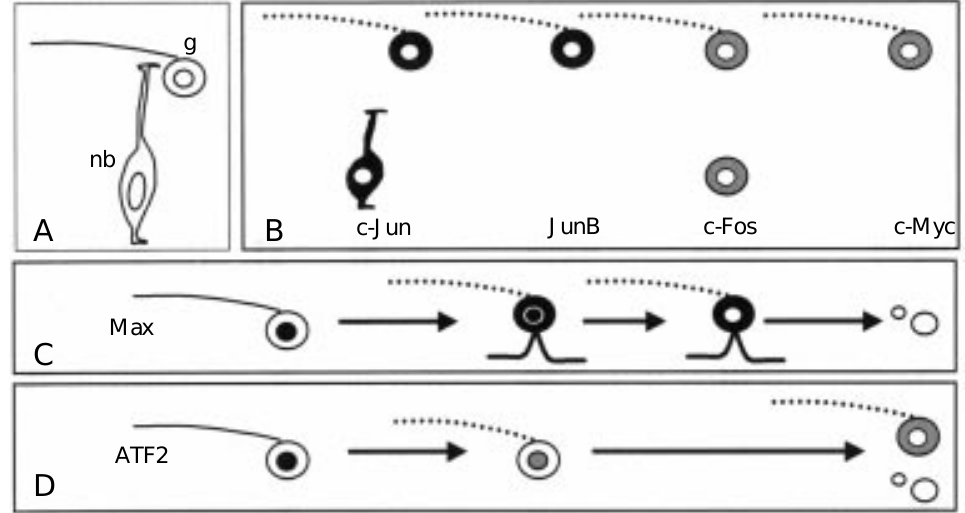
Figure 3 - Nuclear exclusion of transcription factors in retinal ap- optosis. A , Symbolic depiction of retinal ganglion cells (g) and neuroblasts (nb). B , Representa- tion of the location of immunore- activity detected for 4 transcrip- tion factors in the cell types de- picted in A. Immunoreactivity for c-Fos and c-Myc was less in- tense than obtained for c-Jun and JunB in our conditions. C and D , The course of nuclear ex- clusion of Max and ATF2, as de- tected by immunocytochemistry in retinal ganglion cells at pro- gressively longer periods after axotomy due to explantation. Max was analyzed in explants from rats at P13, while all others were studied in explants from newborn rat retinae. The twin circles at the far right in C and D represent fragmented apoptotic bodies unlabeled for either tran- scription